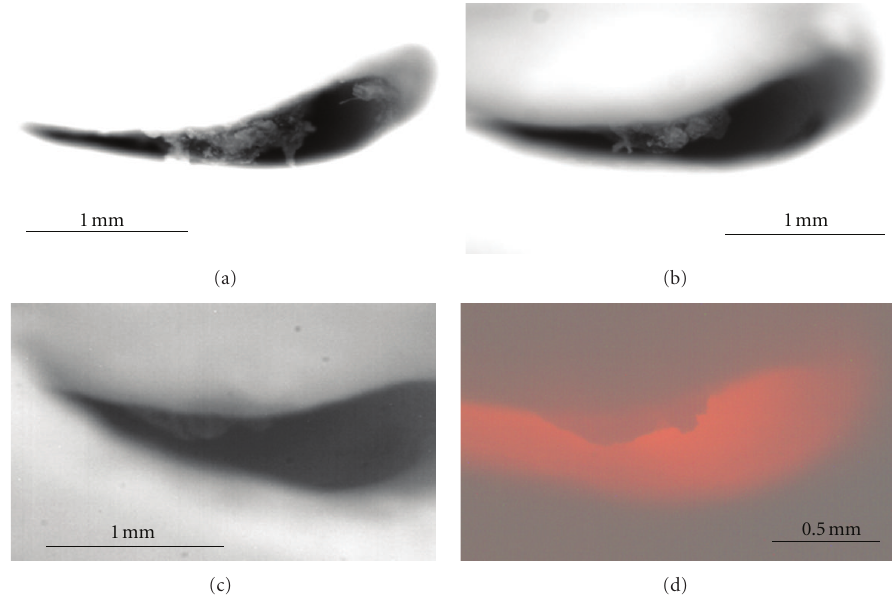
Figure 5: Stereomicroscope images of organisms in untreated (a), 20 pulses (b), and 40 pulses (c, d) laser irradiation-treated root canal gap.